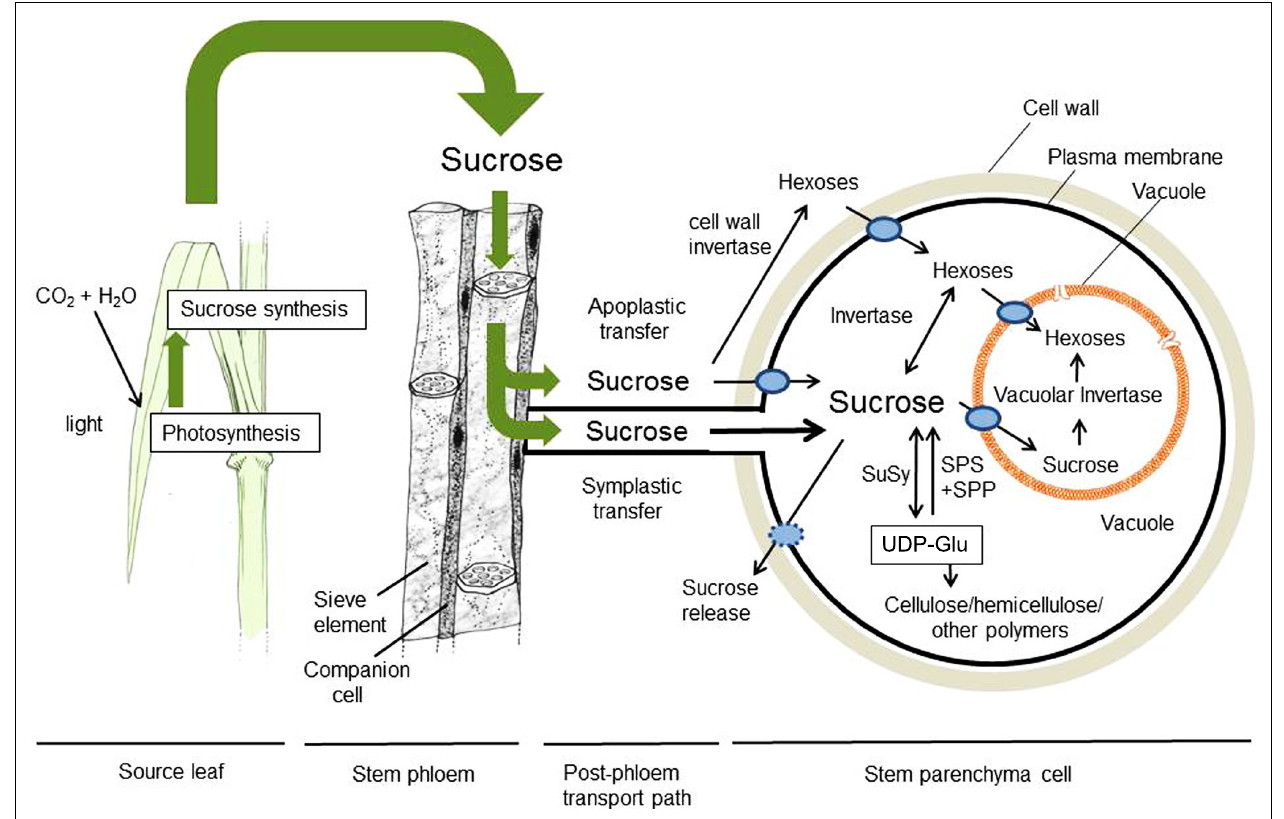
FIGURE 1 | Process diagram for sucrose movement and metabolism in sugarcane from its synthesis in source leaves to its deposition in stems. Sucrose movement is shown with green arrows, and its subsequent metabolism and compartmentalization with narrow black arrows.Transporters are shown with blue ovals, cell wall is designated with a wide tan circle, and the vacuole is shown in orange. Sucrose synthesized in photosynthetic leaves is translocated in phloem to stem parenchyma cells, where its post-phloem transfer can follow two paths: symplastic (through plasmodesmata, as thought to predominate in the mature sugarcane internodes) and/or apoplastic (through the cell wall space considered a possible contributor earlier in sugarcane stem growth). Sucrose can move unaltered to